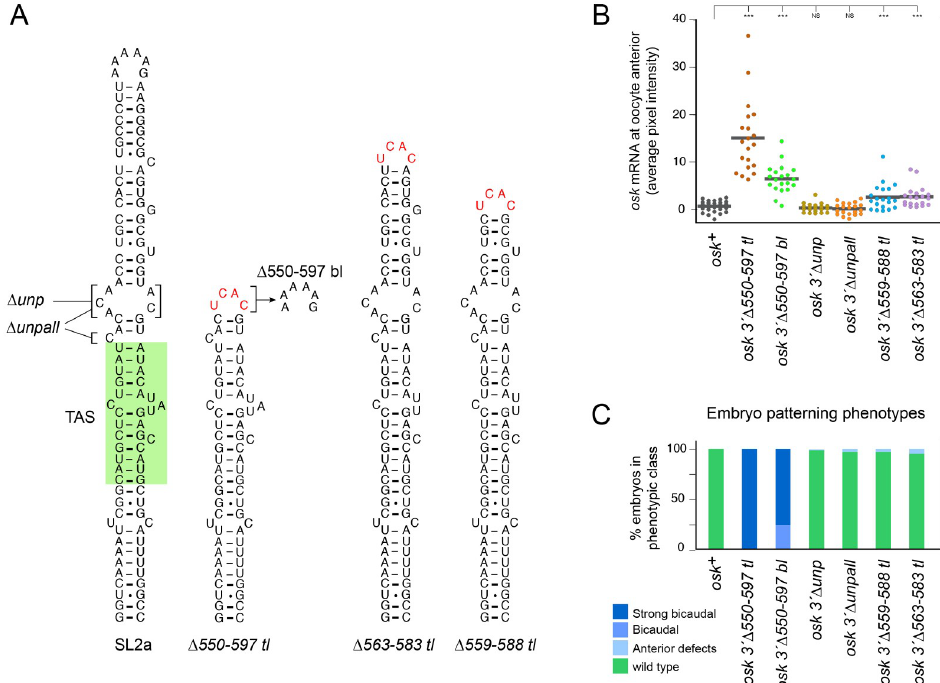
Fig 2. Mutational analysis to identify changes to SL2a that enhance its transport and anchoring activity. (A) Wild- type and mutant forms of SL2a tested in genomic osk transgenes as in Fig 1. Changes to wild type, or to the mutant with enhanced transport and anchoring, are indicated on the structures with tetraloops in red. (B) Quantitation of anterior retention of the indicated osk transgene mRNAs in late stage 9 oocytes, measured as described in Methods and materials and presented in dot plot format. At least 20 egg chambers were analyzed for each genotype. Statistical significance was evaluated by one-way ANOVA with F(6,143) = 51.90, P < 2 x 10 − 33 . Normality was rejected (Bonferroni corrected Shapiro-Wilk test), therefore the Wilcoxon rank sum test was used for post hoc analysis. ��� : P < 0.01, NS: not significant. (C) Axial patterning of embryos from mothers with osk genes as indicated. Mutant phenotypes, from mislocalized osk activity, are defined as in Fig 1 with the addition of bicaudal (3 or more duplicated abdominal segments). N values for all genotypes were greater than 300.